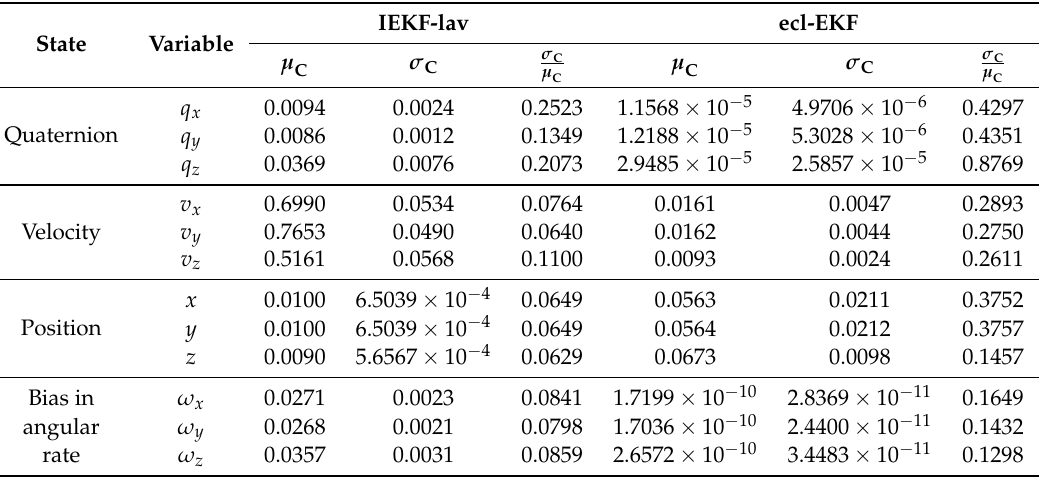
Table 6. Comparison of error covariance for estimation of location, attitude, and velocity in fixed wing flight